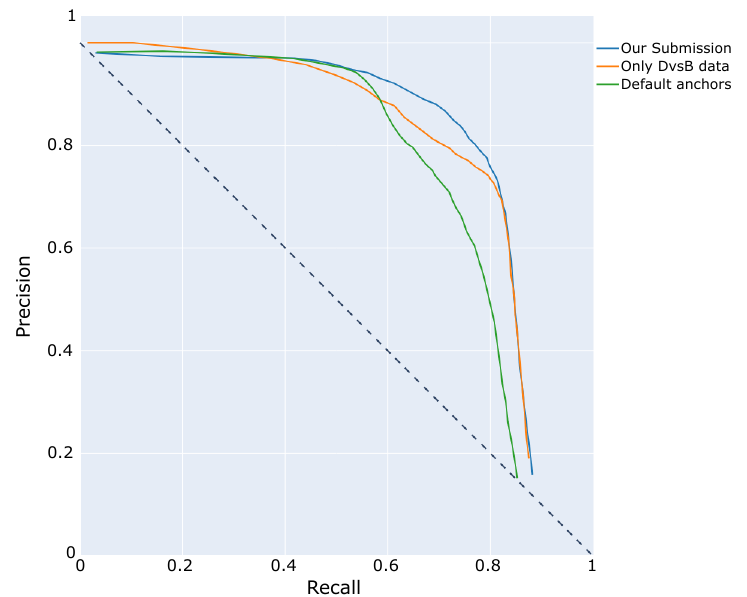
Figure 9. Precision vs. Recall at IoU =